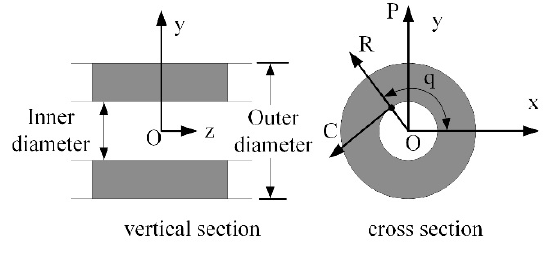
Figure 2. Simplified pipeline model.